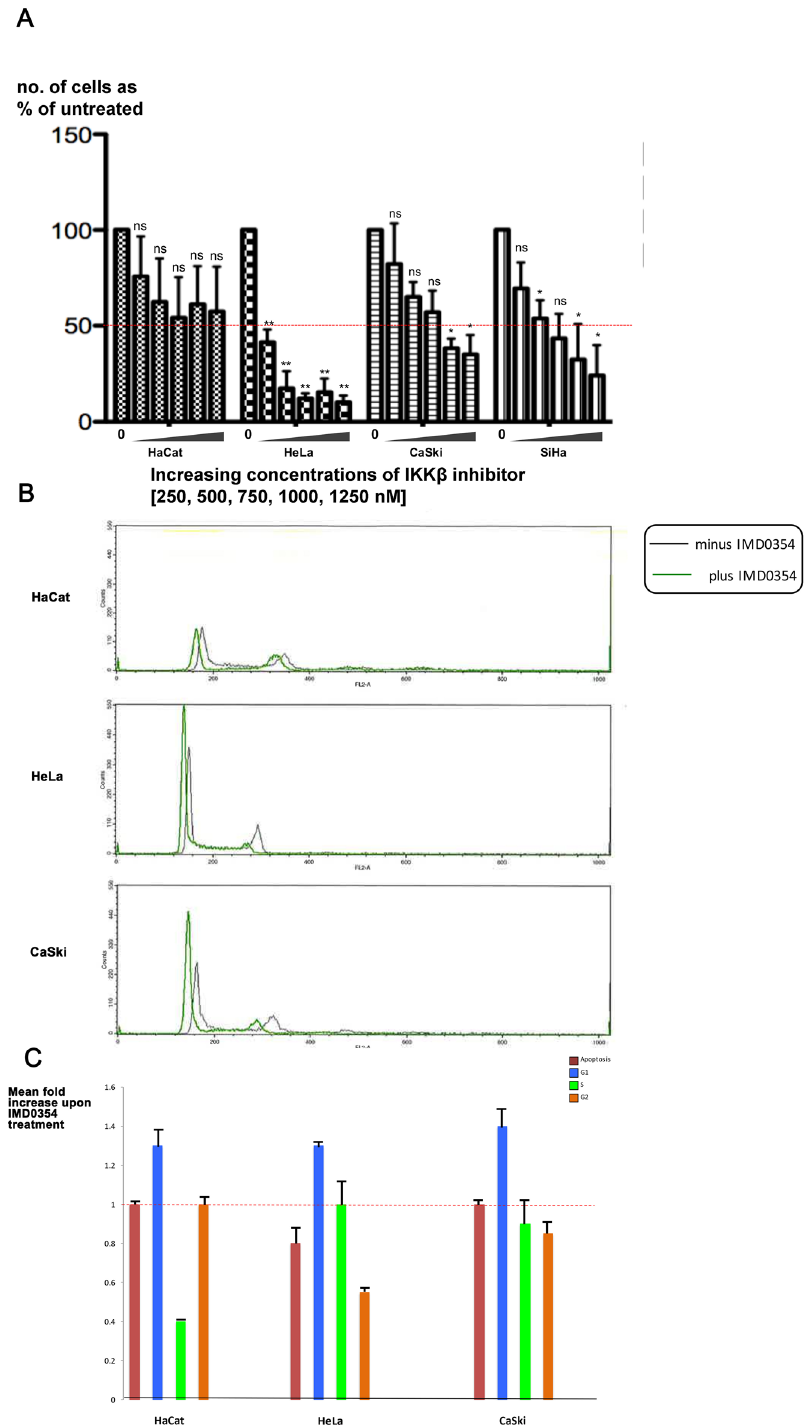
Figure 2. Inhibition of Human IKKβ in cervical cancer cells blocks their growth. ( A ) Five different concentrations (250, 500, 750, 1000, 1250 nM) of human IKKβ inhibitor, IMD 0354, were applied to HPV-negative (HaCat), HPV 18-positive (HeLa), and HPV 16-positive (CaSki and SiHa) cells and the effect was measured by number of surviving cells after 48 h. The inhibitor blocks the growth of HPV 16 and 18 cervical cancer cells without a significant effect on the HaCat cells, showing a most significant effect on HeLa cells: reducing the initial number of cells to 40%, at starting concentration of 250 nM and 10% at 1250 nM. Data are presented as mean ± SD ( n = 3); not significance (n.s.) = P > 0.05; * P < 0.05, ** P < 0.01. One-way ANOVA test using the Prism program was used for statistical analysis. ( B ) HPV-negative (HaCat), HPV 18-positive (HeLa), and HPV 16-positive (CaSki) cells were treated with 500 nM of human IKKβ inhibitor, IMD 0354, or with DMSO as control. After 3 h cells were trypsinized and stained with Propidium Iodide, and the cell cycle profiles were analysed by FACS. n = 4. Representative cell cycle profiles are shown for each cell type and condition. ( C ) The cell cycle FACS profiles were analysed to determine the number of cells in subG1 (i.e. apoptotic), G1, S and G2M phases of the cell cycle. The histogram shows the results from four experiments expressed as the fold change in cell number upon IMD 0354 treatment, relative to DMSO treatment. Standard deviations are shown. The assay was repeated 4 times, n =